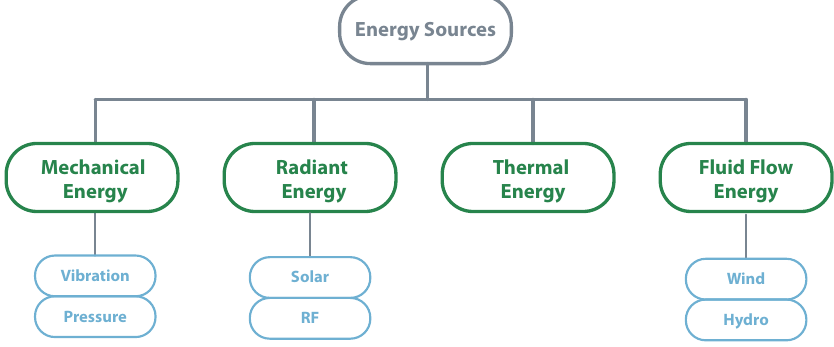
Figure 8. Most used energy sources for energy harvesting.